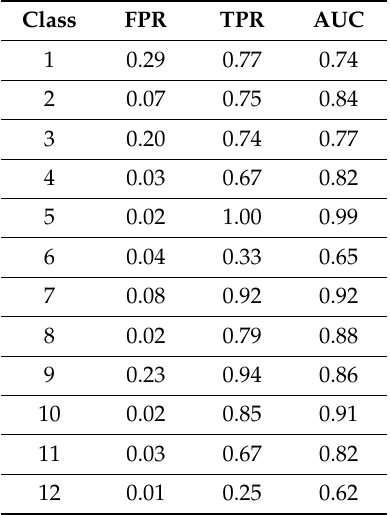
Table 6. Obtained TPRs vs. FPRs, for ROC curves, from the well trained and tested feed-forward, multilayer ANN applied on the class-imbalanced test data; for the 12 classes the AUCs obtained are also shown.